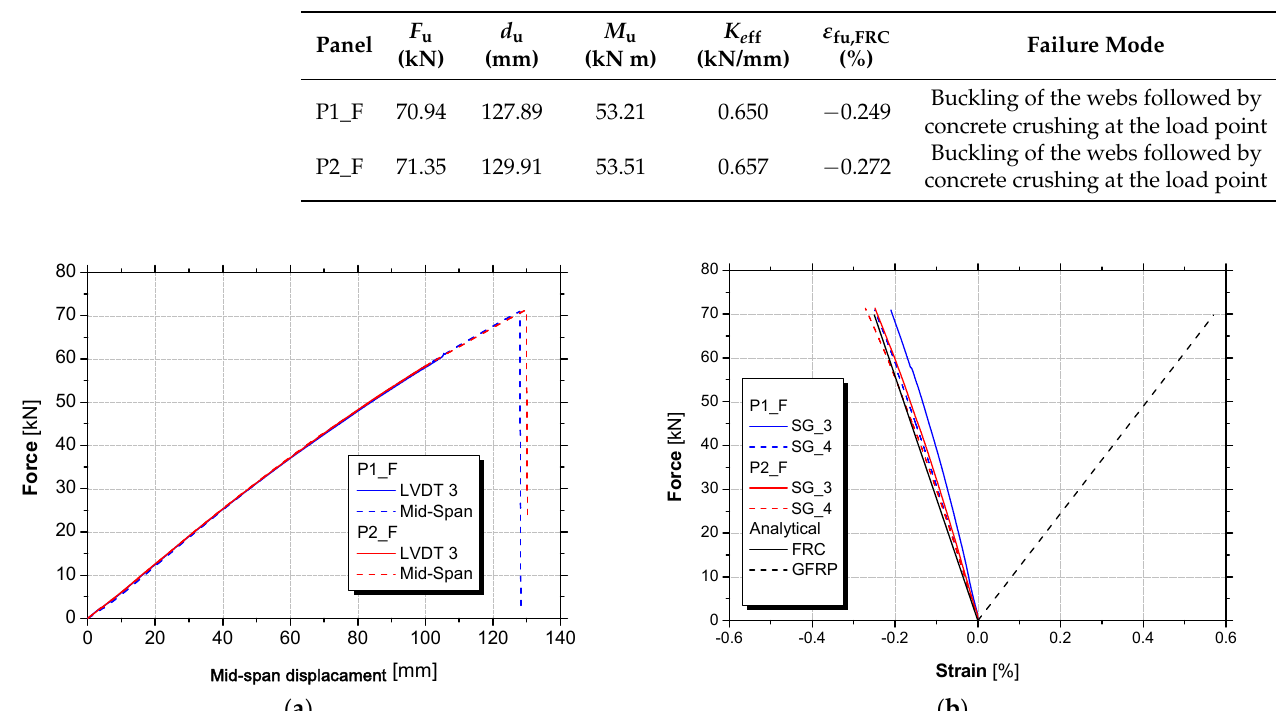
Table 8. Main results from the four-point bending tests.